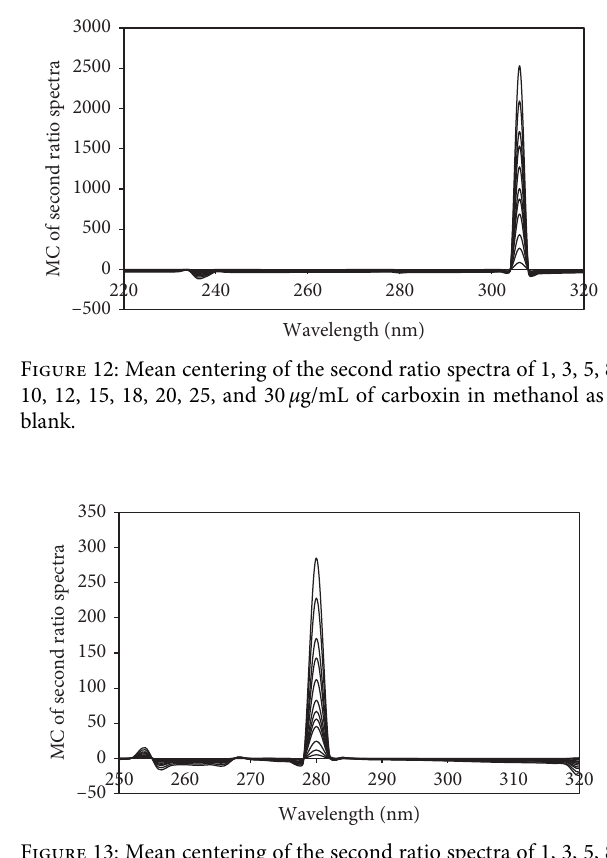
Figure 13: Mean centering of the second ratio spectra of 1, 3, 5, 8, 10, 12, 15, 20, 25, 30, 40, and 50 μ g/mL of chlorpyrifos in methanol as a